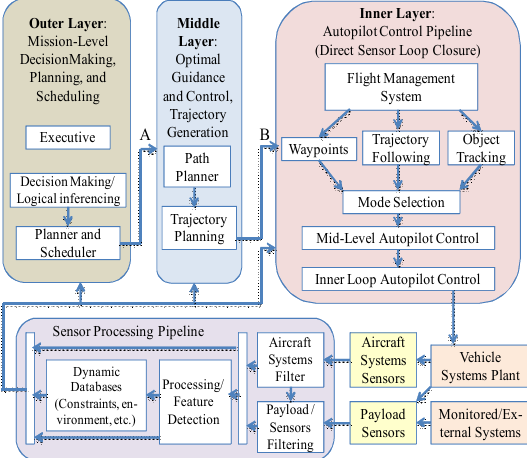
Figure 9. Three-level payload directed flight